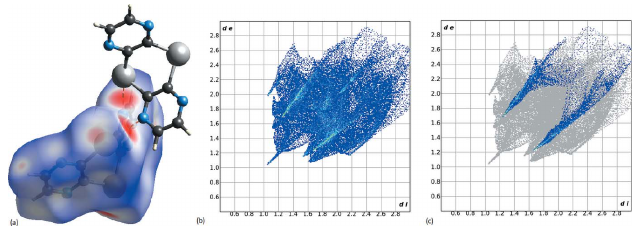
Figure 5 ( a ) Hirshfeld surface mapped over d norm , ( b ) two-dimensional fingerprint plot, ( c ) two-dimensional fingerprint plot with reciprocal N (cid:2) (cid:2) (cid:2) Te contacts